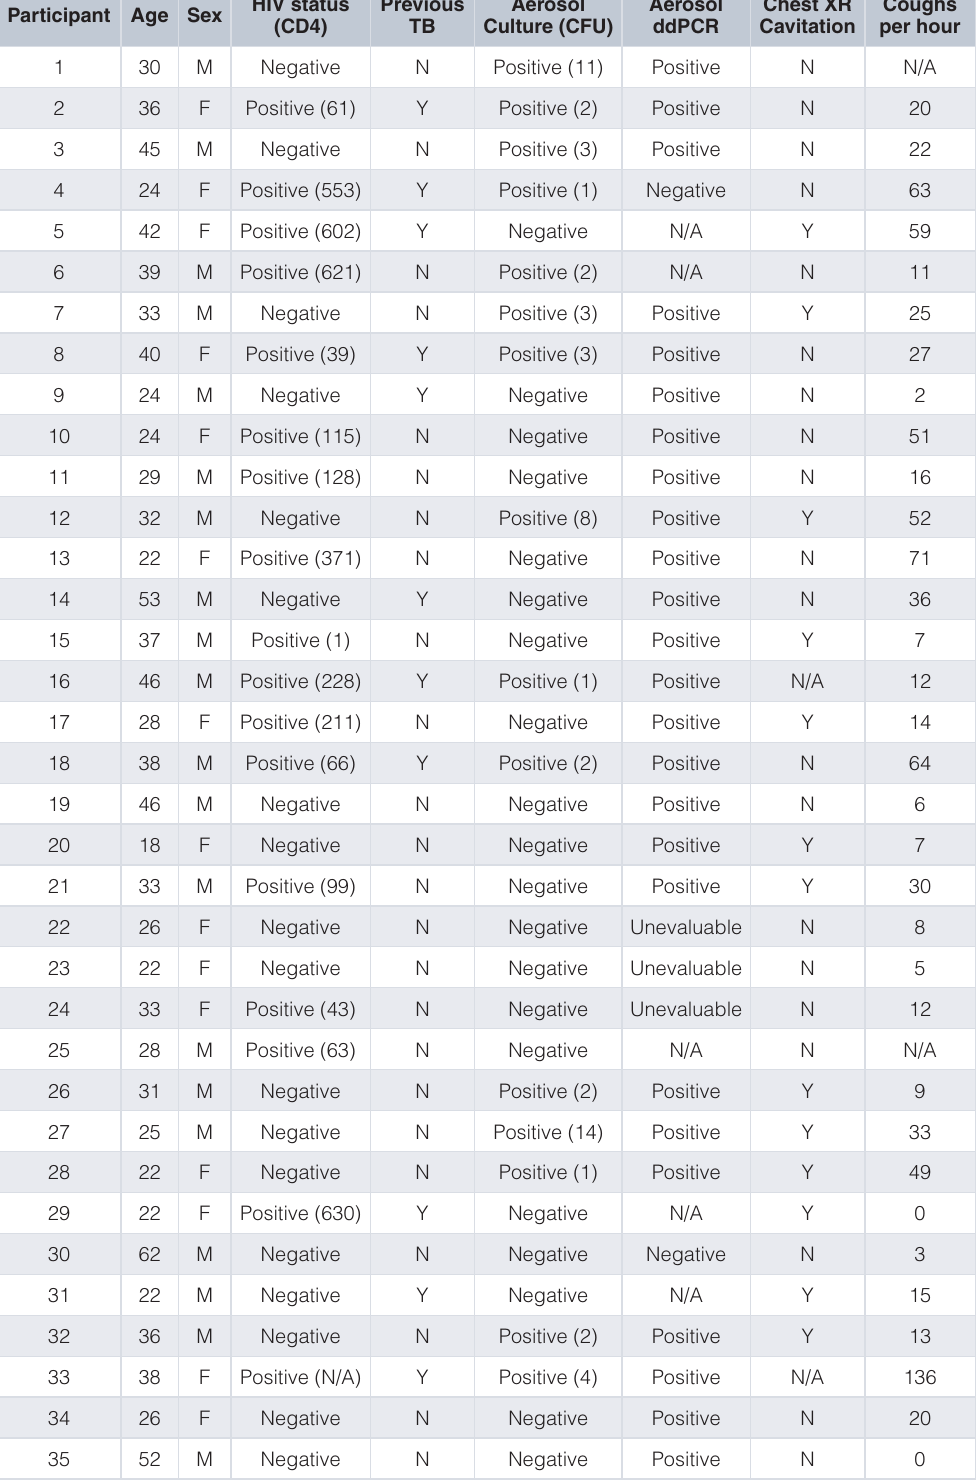
Table 1. Baseline characteristics of RASC